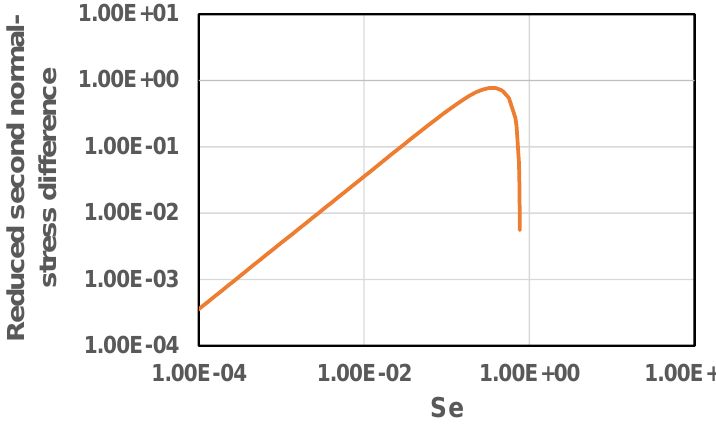
Figure 15. Reduced second normal-stress difference − N 2 r / φ as a function of Se for suspensions of soft-solid particles.